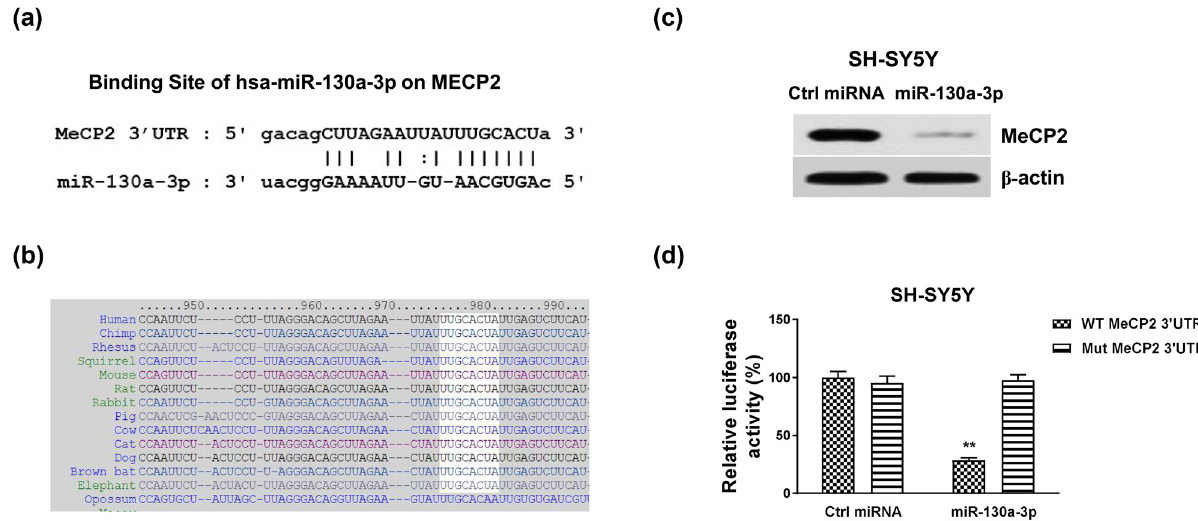
Figure 3: MeCP2 is directly targeted by miR - 130a - 3p. ( a ) Bioinformatics analysis of potential binding of miR - 130a - 3p on 3 ′ UTR of MeCP2. ( b ) The conserved binding sites of miR - 130a - 3p on 3 ′ UTR of MeCP2 in multiple species. ( c ) SH - SY5Y cells were transfected with control or miR - 130a - 3p for 48 h; the protein expression of MeCP2 was detected by western blot. ( d ) Dual - luciferase reporter assay was performed in SH - SY5Y cells with co - transfection of WT - MeCP2 or Mut - MeCP2 with control miRNA, or miR - 130a - 3p. ** p < 0.01.